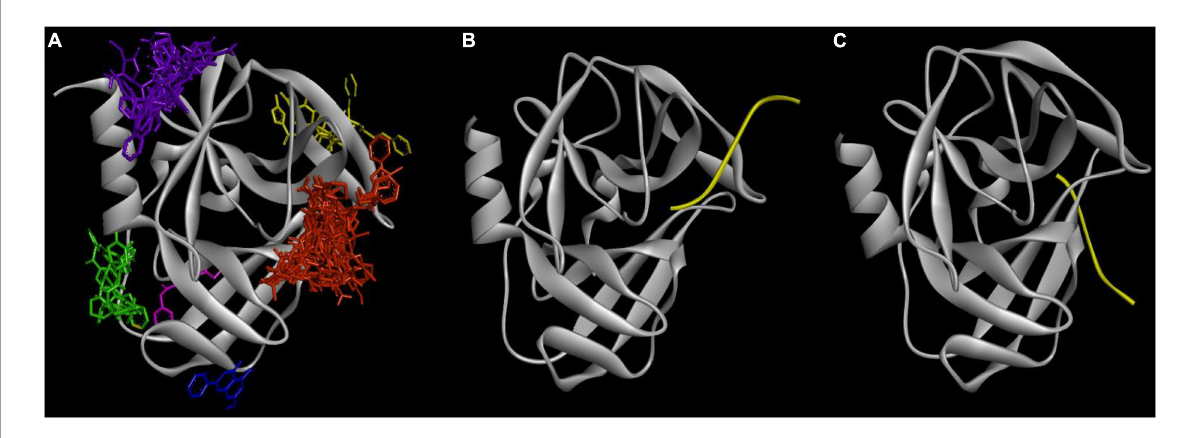
FIGURE3 The consistency between in silico with in vitro experiments: (A) six popular clusters with different colors were made between 21 candidates with the 5C1U: red—cluster 1, green—cluster 2, purple—cluster 3, yellow—cluster 4, blue—cluster 5, and pink—cluster 6; and the crystallography model of (B) 3SJ9 and (C) 3SJK between 3C pro protein (gray color) with its targeted peptide (yellow color) (Lu et al., 2011). The figure was illustrated by Python-based Molecular View with a ribbon-shaped proteins or polypeptide and atom-shaped ligands.